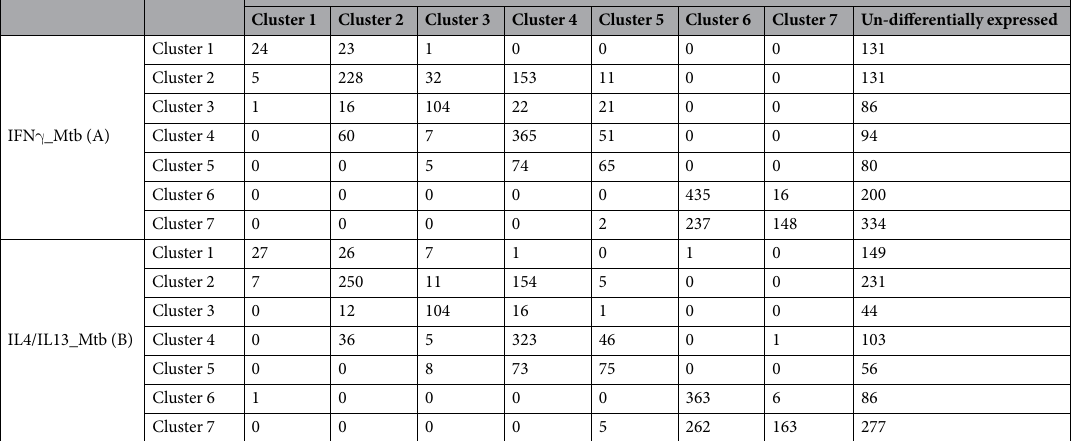
(more or less than 3-fold) in IFN γ _Mtb (Fig. 4a,b and Supplementary Table S6a to S6d). We found that many of the well characterized IFN γ -induced M1 effectors, such as Nos2 , Cxcl10 , Cxcl9 , Cxcl11 , Gbp5 , Timd4 , Tgtp1 , Tgtp2 , Serpinb9 were drastically enhanced by IFN γ pre-stimulation (Fig. 4a). Interestingly, Cxcl10 , Cxcl9 , Cxcl11 and particularly Nos2 , which subsequently protect macrophages from mycobacterial infection, were drastically enhanced and continuously expressed till 48 h in IFN γ _Mtb (Fig. 4c). These transcriptional reprogramming